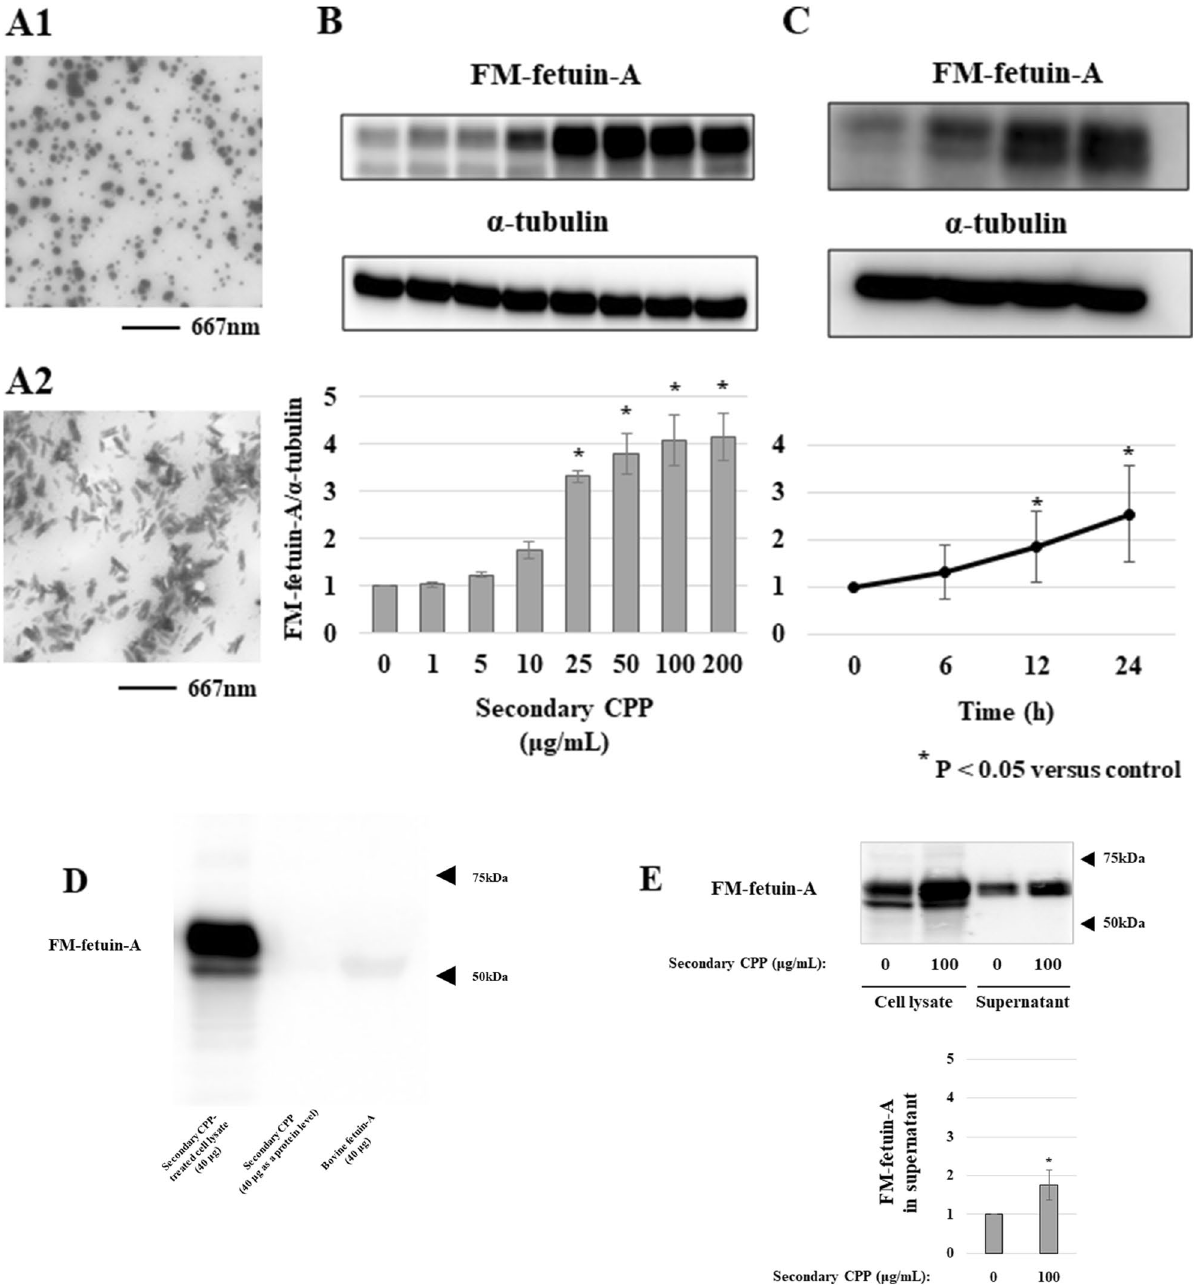
Figure 1. TEM imaging of synthetic CPP and effects of secondary CPP on FM-fetuin-A in HepG2 cells. ( A1 ) After 1.5 h of incubation of CPP solution, small spherical-shaped CPP (primary CPP) were formed. ( A2 ) At 24 h, larger crystalline-like CPP (secondary CPP) were observed. ( B ) HepG2 cells were treated with different concentrations (0, 1, 5, 10, 25, 50, 100, and 200 μg/mL) of synthetic secondary CPP for 24 h. Immunoblots of cell lysates were probed with fetuin-A ( B , upper panel) and α-tubulin ( B , middle panel) antibodies. FM-fetuin-A levels were quantified using α-tubulin as an endogenous reference ( B , lower panel), with the fetuin-A level without CPP defined as 100% (control). ( C ) HepG2 cells were treated with 100 μg/mL secondary CPP for 0, 6, 12, 24 h. Immunoblots of cell lysates were probed with fetuin-A ( C , upper panel) and α-tubulin ( C , middle panel) antibodies. FM-fetuin-A levels were quantified as above ( C , lower panel), with the fetuin-A level at 0 h defined as 100% (control). Data are shown as mean ± SD from at least three independent experiments. ( D ) Cell lysate from 100 μg/mL secondary CPP-treated HepG2 cells, 40 μg of secondary CPP as a protein level, and 40 μg of bovine fetuin-A were probed with human anti-fetuin-A antibody. ( E ) HepG2 cells were treated with or without 100 μg/mL secondary CPP for 24 h. Cell Lysate and the supernatant from cultured HepG2 cells were probed with an anti-fetuin-A antibody. *P < 0.05 vs. control. Full-length blots/gels ( B , C , D , E ) are presented in Supplementary Fig. X1 (full-size) ( B , B ′ , C , D , D ′ , E , E ′ ),